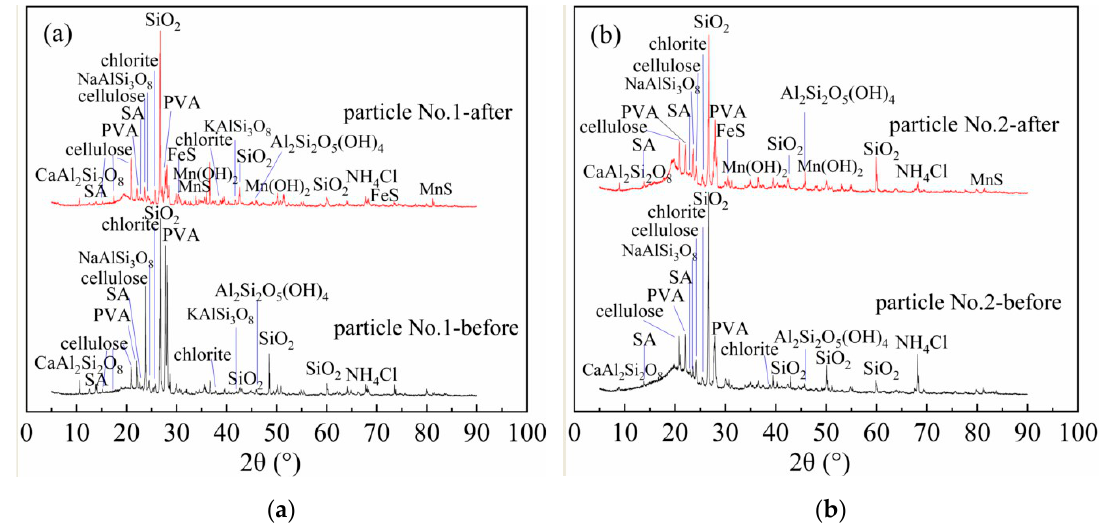
Figure 4. X-ray diffraction (XRD) patterns of particles before and after treating AMD. ( a ) Particle No.1; ( b ) Particle No.2.